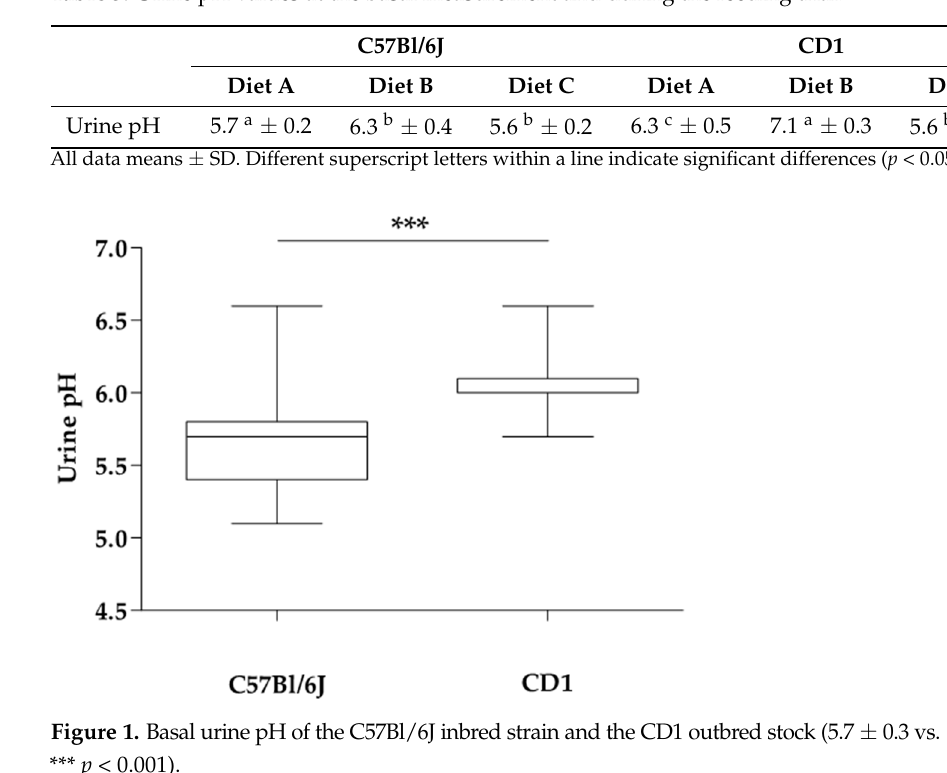
Table 3. Urine pH values at the basal measurement and during the feeding trial.